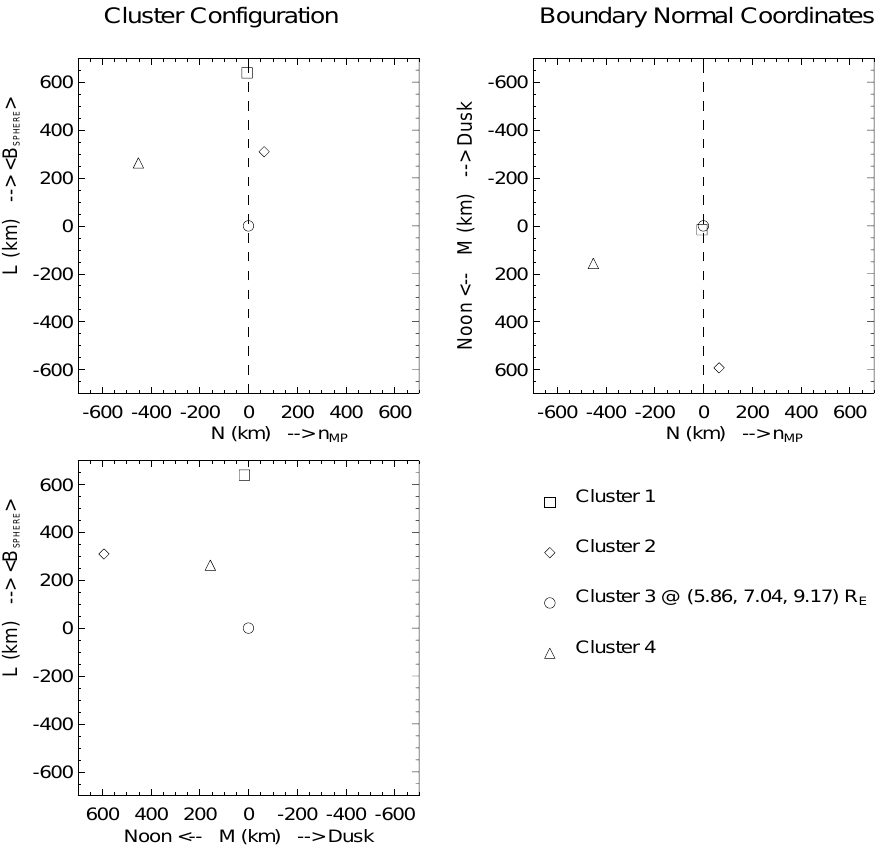
Fig. 1. The configuration of the Cluster quartet at ∼ 14:00UT on 2 February 2001, given in the boundary normal coordinate system determined from the Fairfield (1971) model magnetopause. The top left panel shows the projection of the spacecraft positions onto the LN plane, the top right panel shows the projection onto the MN plane and the bottom left panel shows the projection onto the LM plane. The latter represents the plane of the magnetopause, the cross section of which is indicated by the dashed line on the upper two panels. Note that C1, C2 and C3 lie in a plane which is almost parallel to the magnetopause, with C2 located closest to the noon meridian. C4 lies deeper inside the magnetosphere. The spacecraft separations are of the order of 600km at this